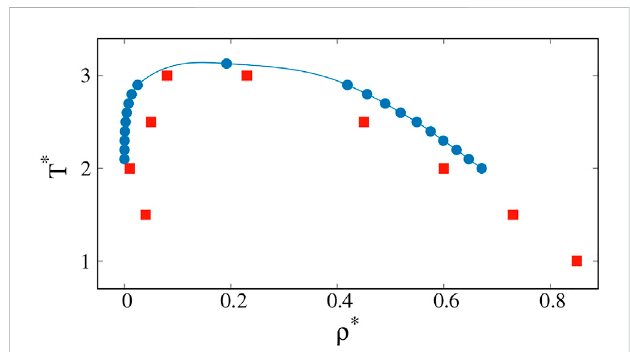
FIGURE 6 Coexistence curves (binodal lines) for chain of monomers calculated by Kevin S. Silmore et al. (2017) (blue circles) and obtained from our simulations based on speci fi c heat analysis (red